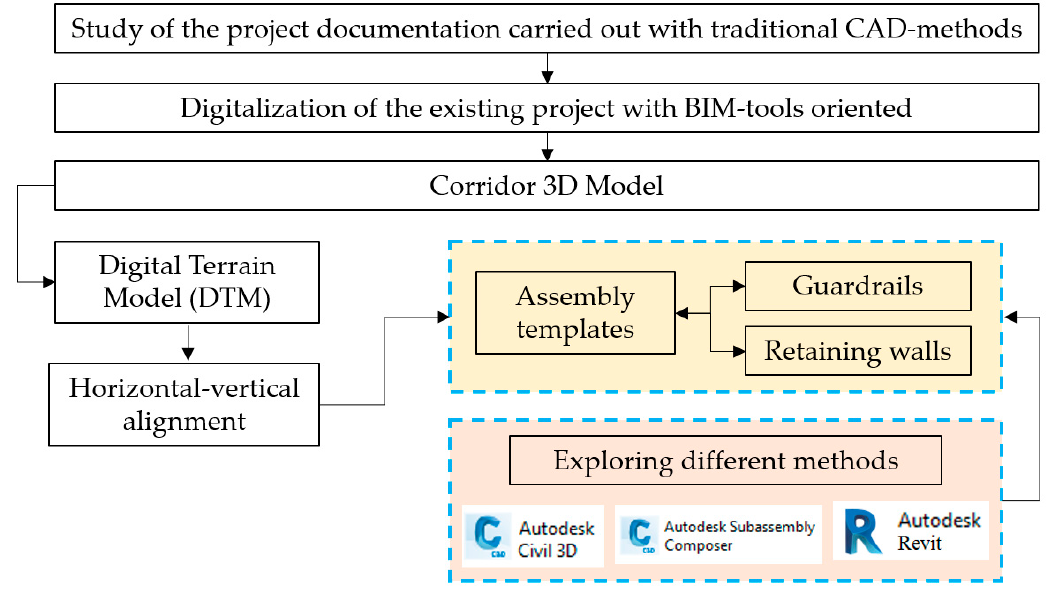
Figure 1. Process methodology overview.